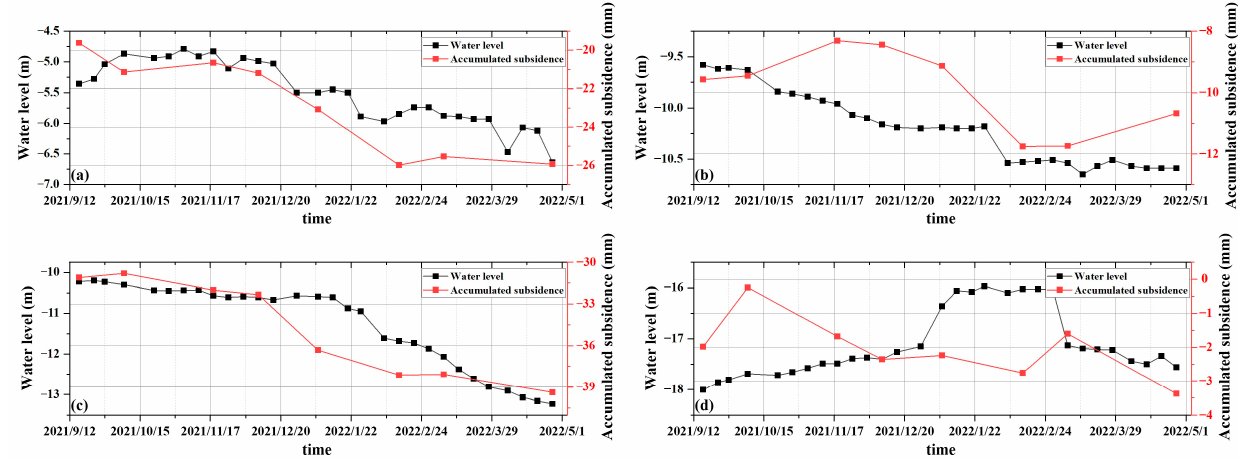
Figure 10. Comparison of groundwater level and average cumulative deformation variables. ( a – d ) are the changes in groundwater level wells ( a – d ), respectively.